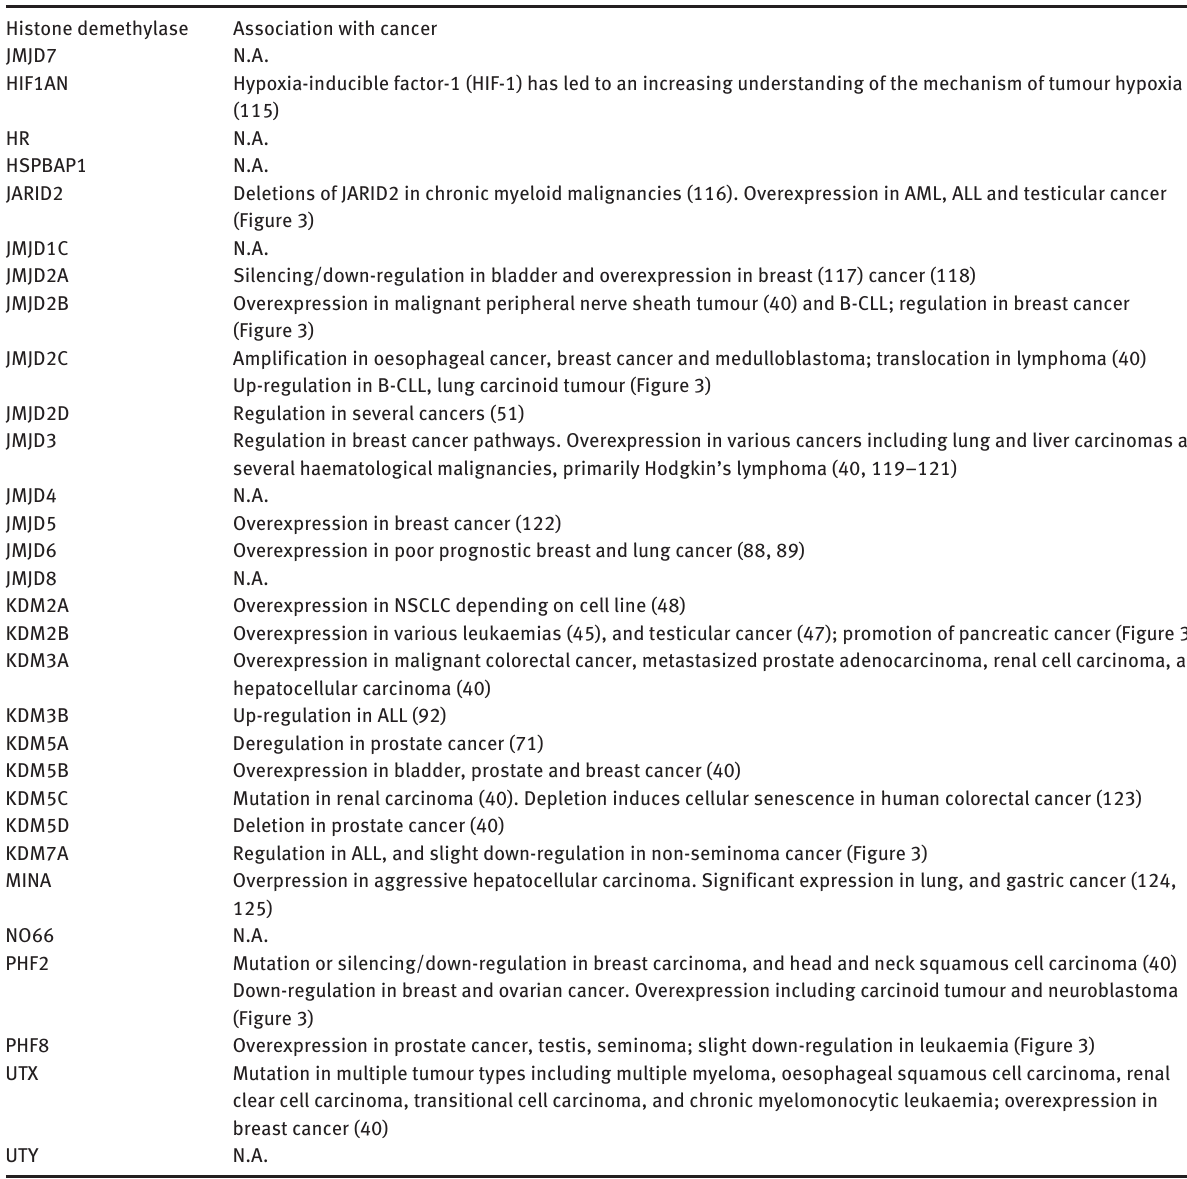
Table 2 JmjC family implication in